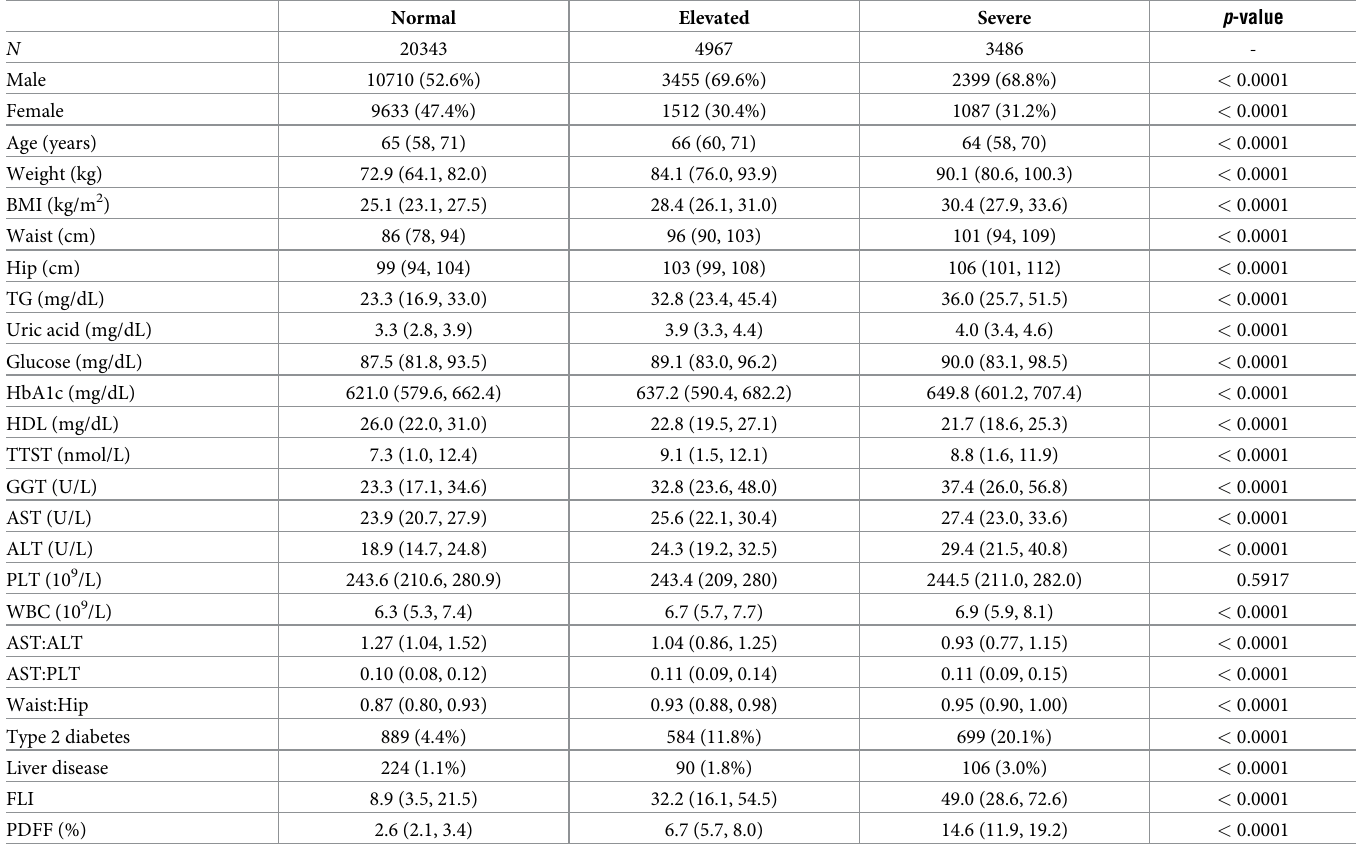
Table 2. Comparison of anthropometric, biochemical and clinical subject characteristics. Normal Elevated